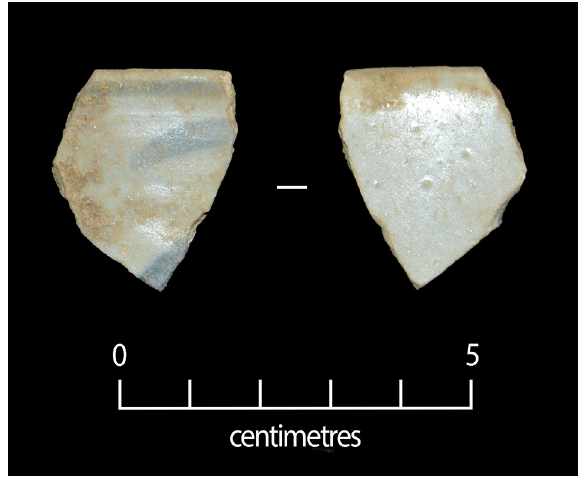
Figure 36: External and internal surfaces of a Class 13